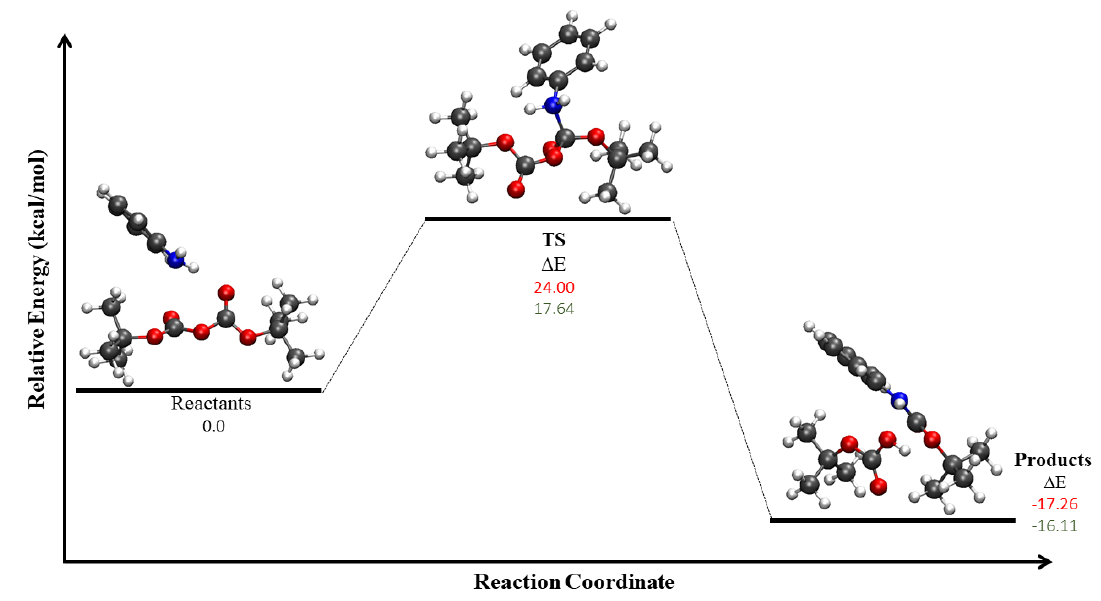
Figure 6. Energy profile for Scheme 1c for gas phase (GP) and dichloromethane (DCM). The figure shows the reaction energy and reaction barrier in the gas phase (red), and with DCM using the SMD implicit solvent model (green).